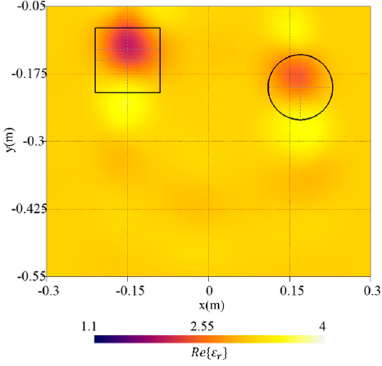
Figure 12. Reconstructed distribution of the real part of the dielectric permittivity, 𝑅𝑒{𝜀 (cid:3045) } , in the investigation domain 𝑅 together with a square box indicating the shape of the actual target. The case of two buried targets with different geometry.